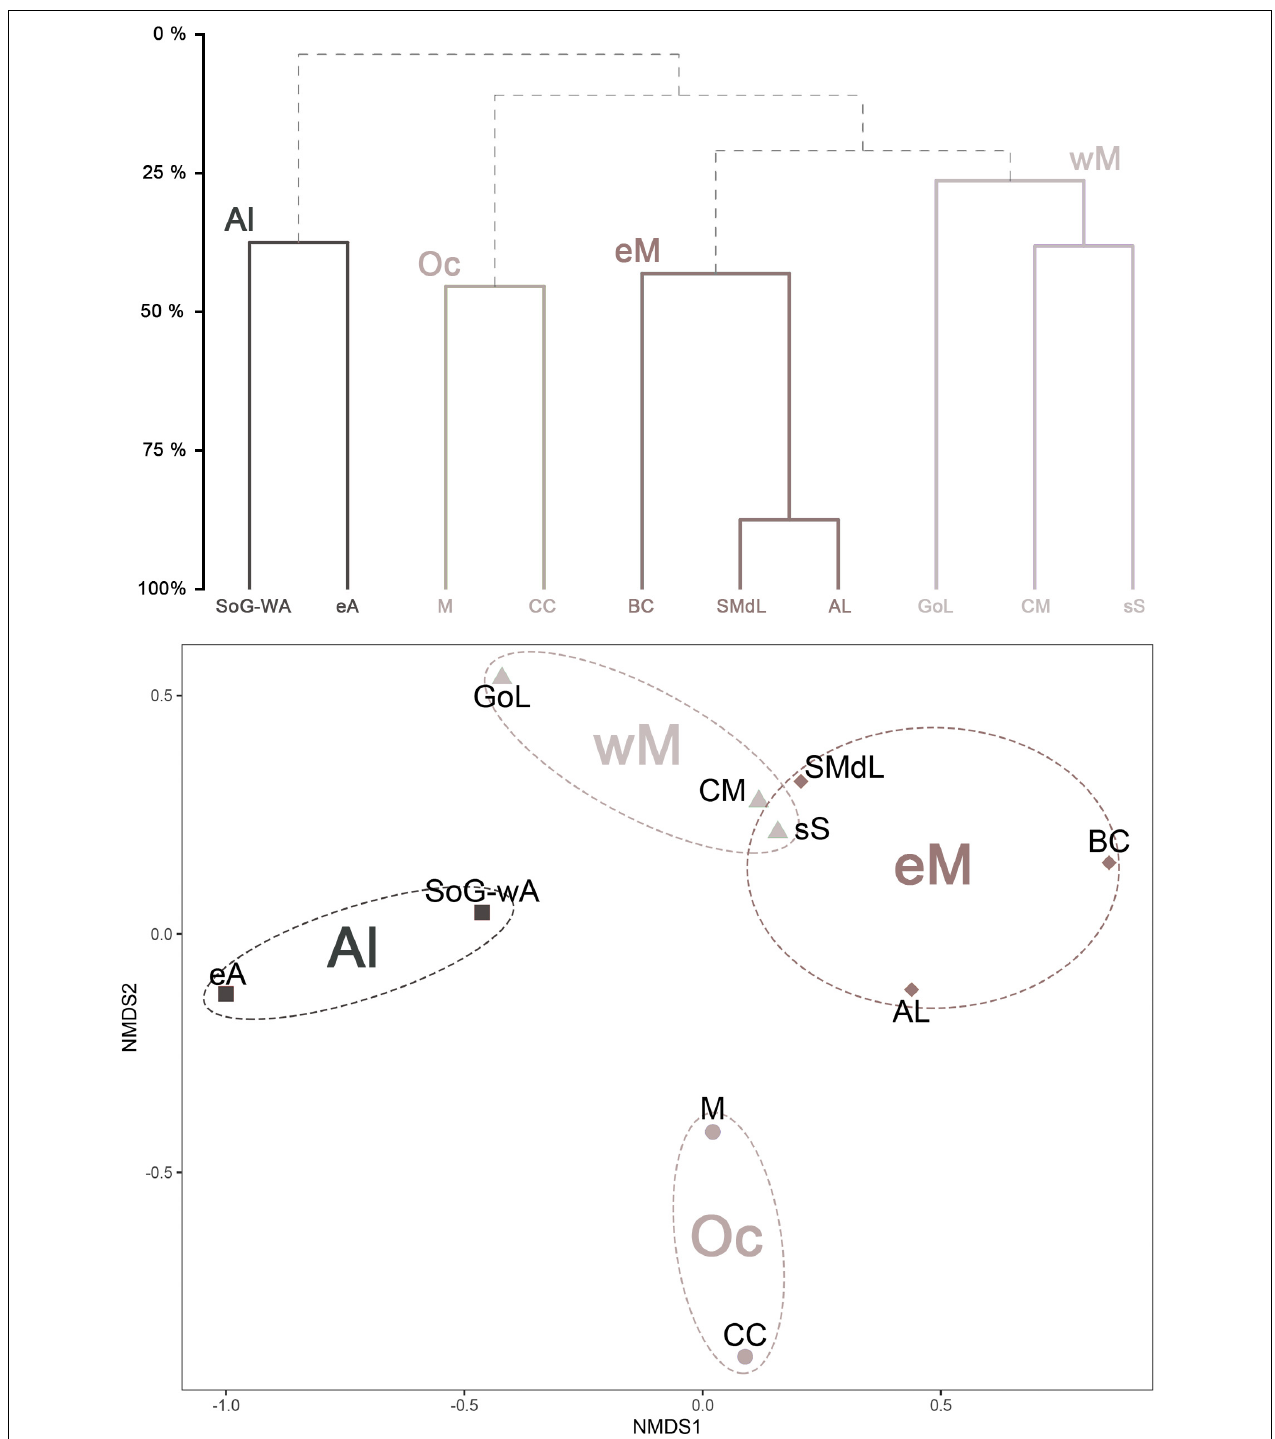
FIGURE 12 | Top: dendrogram representing the sample clustering based on a Bray–Curtis dissimilarity matrix. A 25% similarity threshold was used for clustering. Clusters are differently shaded on a gray-scale to ease visual group identification. Bottom: non-metric multidimensional scaling (nMDS) ordination plot. CWC provinces are represented based on a presence/absence matrix of their associated sponge assemblages. A stress estimate of 0.048 was obtained, indicating a good fit. Clusters are differently shaded on a gray-scale to ease visual group identification, as in the dendrogram. Strait of Gibraltar and western Alboran (SoG-wA); eastern Alboran (eA); Catalan Margin (CM); Gulf of Lions (GoL); South of Sardinia (sS); Corsica Channel (CC); Maltese waters (M); Santa Maria di Leuca (SMdL); Albanian coasts (AL); Bari Canyon (BC); Alboran cluster (Al); western Mediterranean cluster (wM); eastern Mediterranean cluster (eM); Outlier cluster (Oc).